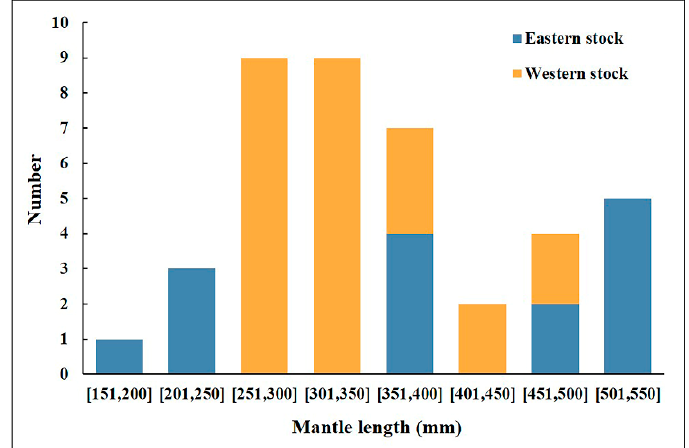
Figure 2. Details of the distribution of the mantle lengths for the eastern and western stocks of O. bartramii .